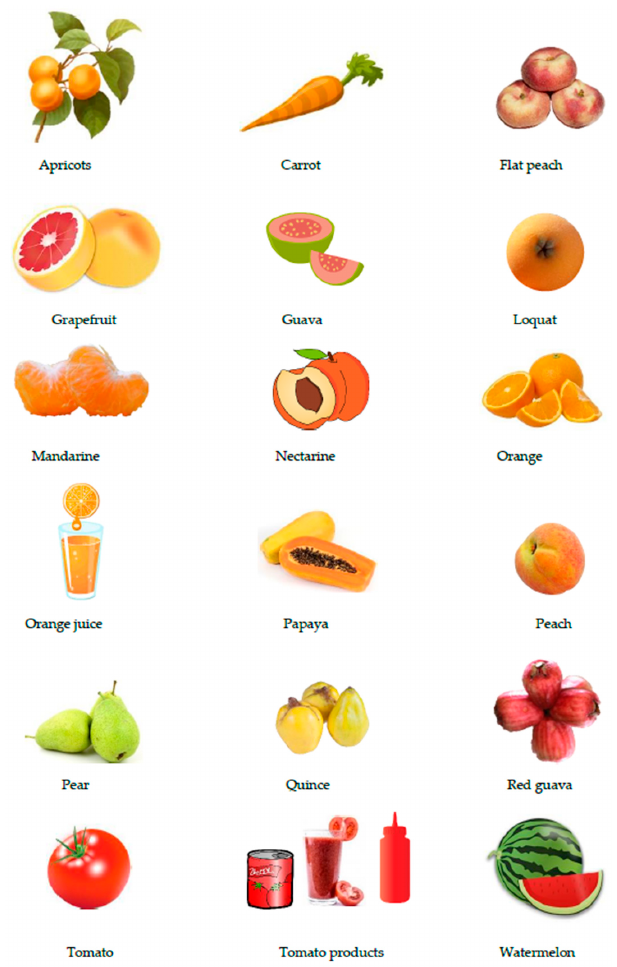
Figure 1. Some sources of colorless carotenoids in Spanish dietary intake.